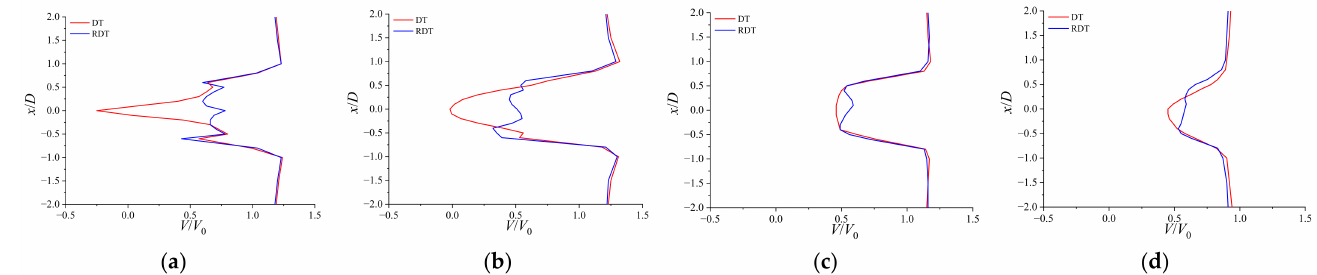
Figure 14. Profiles of mean streamwise velocity for TSR = 3.0 at different streamwise locations in the central x - z plane: ( a ) z / D = 0.5; ( b ) z / D = 1.0; ( c ) z / D = 3.0; ( d ) z / D = 5.0.